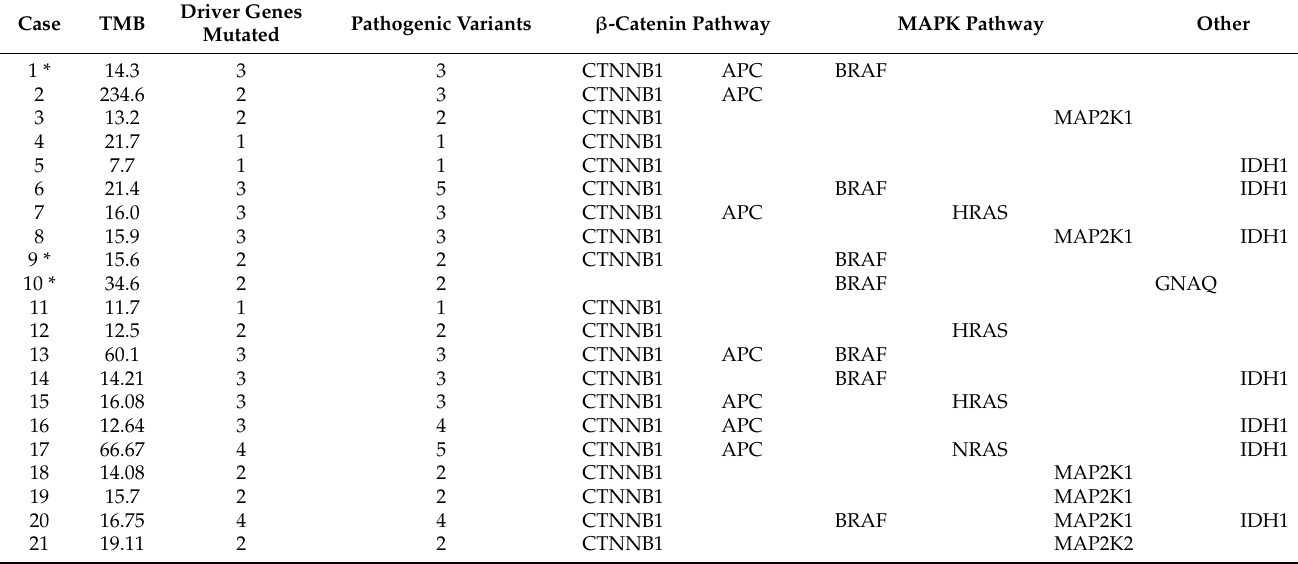
Table 2. Driver gene pathogenic mutations detected in 21 atypical